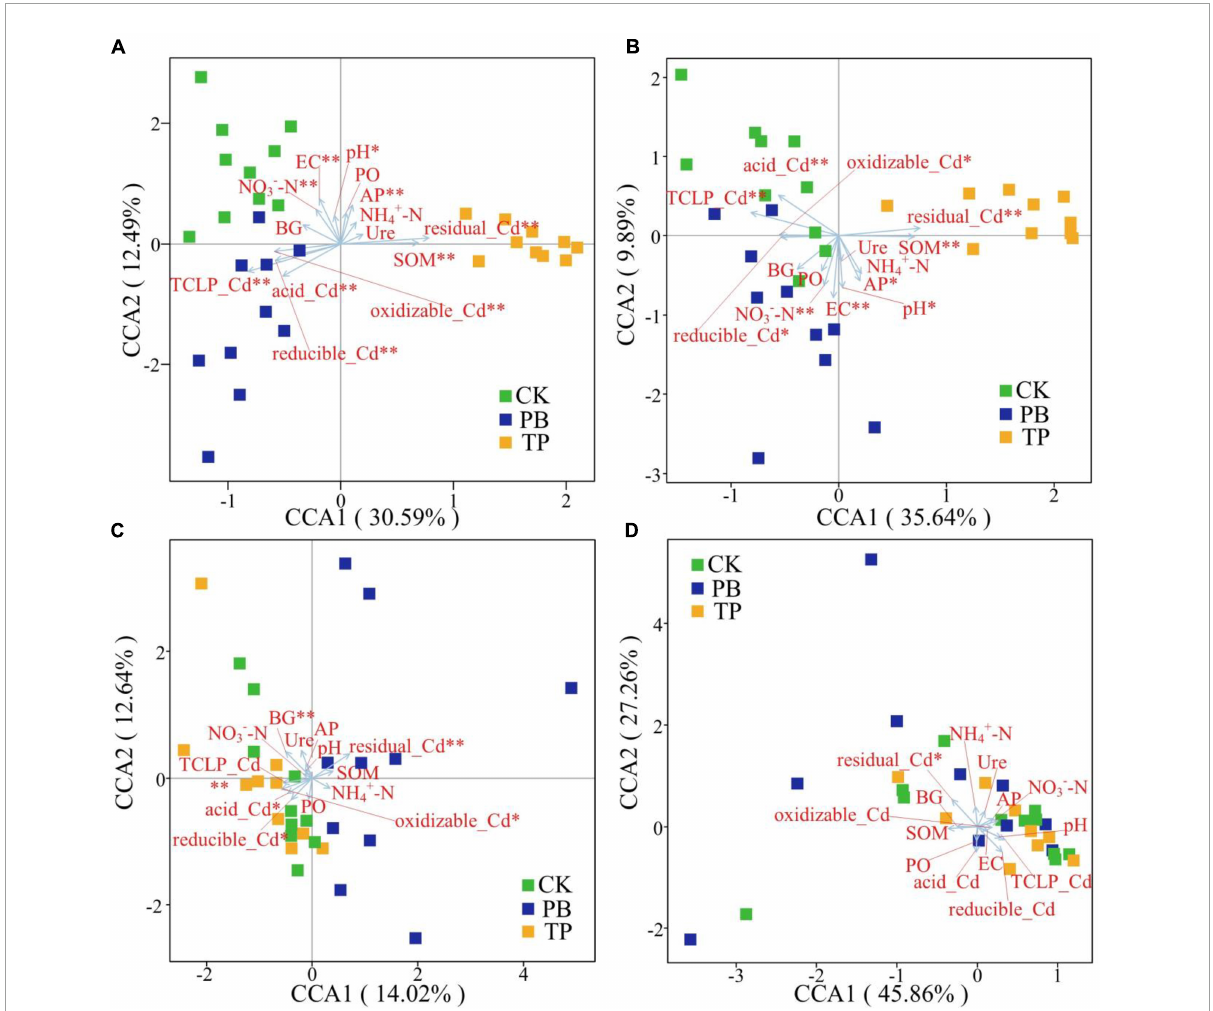
FIGURE6 Identification of driving factors of β -diversity of the rare and abundant microbial communities in soil by Bray-Curtis distance-based canonical correspondence analysis (CCA). EC, electrical conductivity; SOM, soil organic matter; AP, available phosphorus; NO 3 − -N, nitrate nitrogen; NH 4 + -N, ammonical nitrogen; BG, β -glucosidase; Ure, urease; PO, alkaline phosphatase. ∗ Indicates statistically significant. ∗ p < 0.05; ∗∗ p < 0.01. Abundant bacteria (A) , Rare bacteria (B) , Abundant fungi (C) , and rare fungi (D)